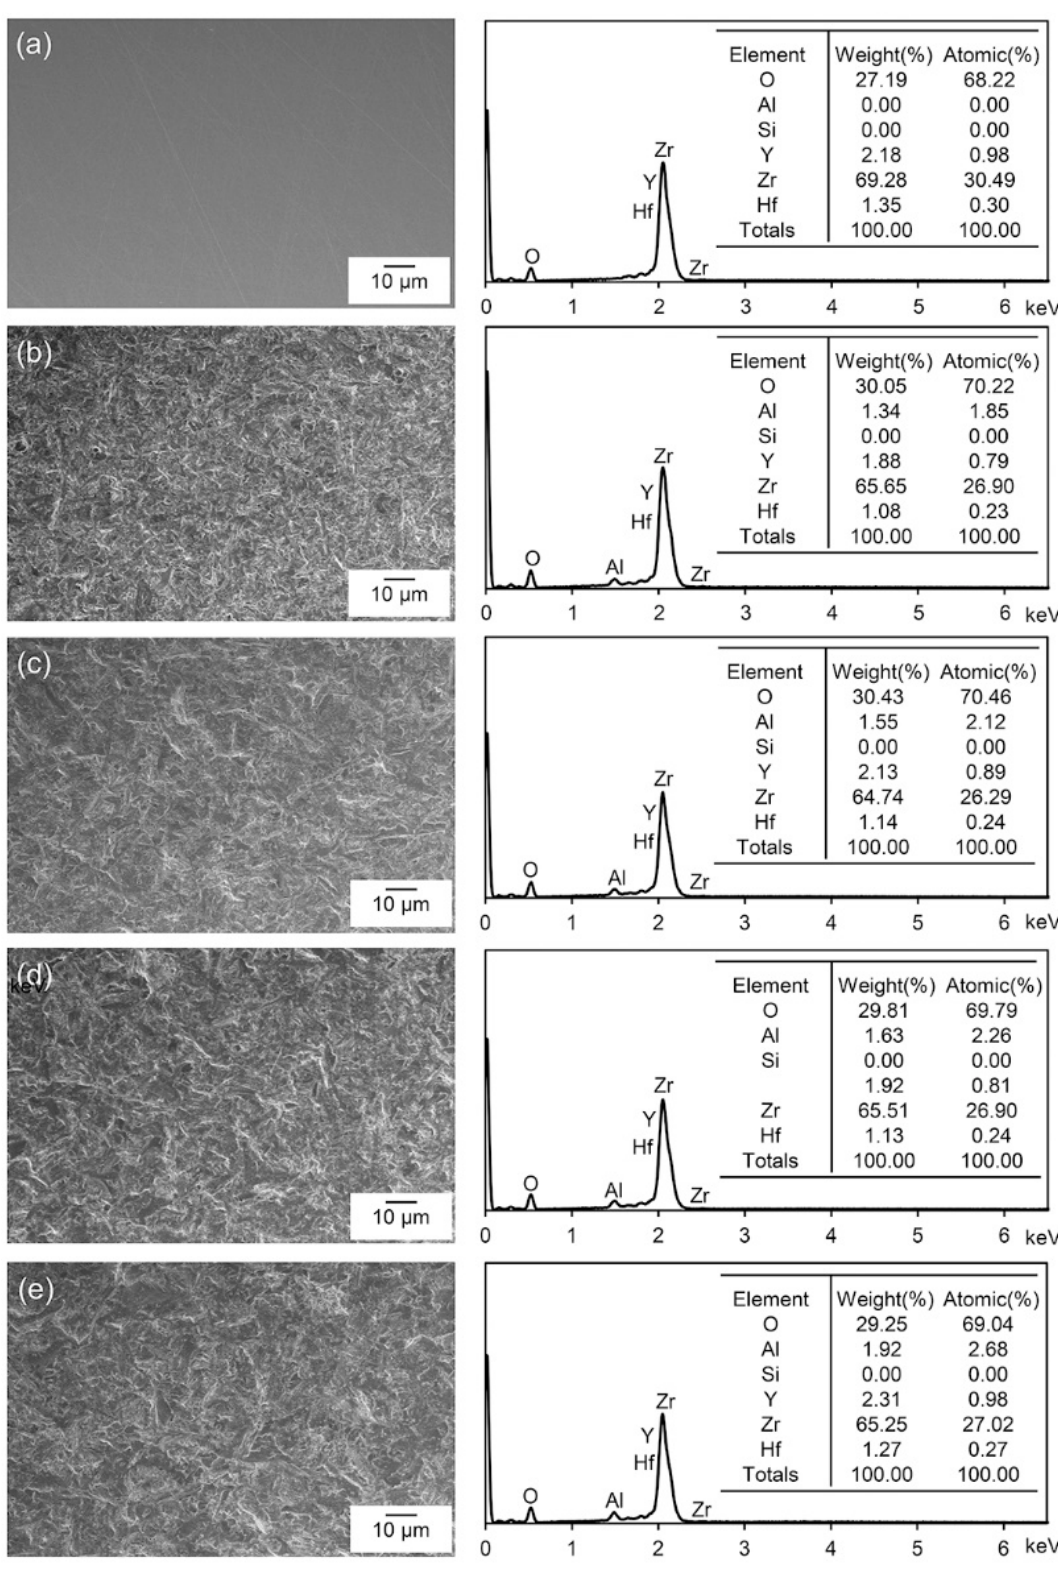
Figure 1. SEM images (1000 × ) of the polished ( a ) and sandblasted ( b – e ) zirconia surfaces and corresponding EDS spectra: ( b ) 50M-2B, ( c ) 50M-4B, ( d ) 110M-2B, and ( e ) 110M-4B.